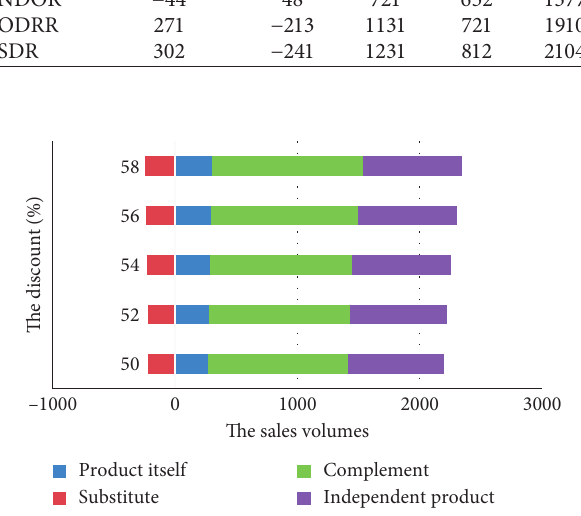
Figure 6: Sales volume under different discount